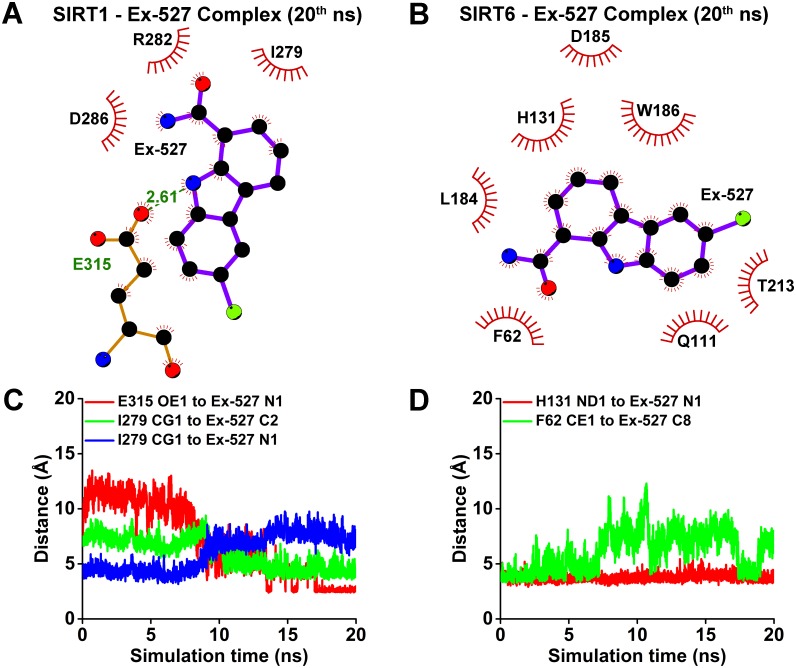
Ex-527 had more hydrophobic contacts and interacted mainly with SIRT6 active site residues compared with Ex-527 of SIRT1.Interaction schemes in (A) and (B) were obtained using Ligplot+ interaction analysis tool on the complex structures of SIRT1-Ex-527 and SIRT6-Ex-527 under high salt at the 20th ns of MD simulations. Legend for the items in (A), (B), (C) and (D) were given as supplementary information (S7 Fig). (A) Ex-527 had only one hydrophobic contact remained with the previously established hydrophobic pocket (I279) and it was held close to the hydrophobic pocket with two other hydrophobic contacts (R282, D286) together with a hydrogen bond to E315 (Bond Length: 2.61 Å). (B) Ex-527 of SIRT6 had more hydrophobic contacts than that of SIRT1 and these contacts were made almost completely with SIRT6 active site residues (H131, W186, F62, Q111, T213). Distance vs. time analysis of the selected contacts observed in (A) and (B) for the whole simulations were given as in (C) and (D), respectively. (C) Side chain carbon (CG1) of I279 of SIRT1 was closer to N1 of Ex-527 for first ~7 ns (blue), while it was nearer to C2 of Ex-527 for the rest of the simulation (green). After ~14 ns, side chain oxygen (OE1) of E315 of SIRT1 was in close proximity of N1 of Ex-527, corresponding to the newly formed hydrogen bond (red). (D) For the first ~6 ns, side chain carbon (CE1) of F62 of SIRT6 was closer to the C8 of Ex-527, but this adjacency was fluctuated for the rest of the simulation (green). Yet, active site H131 of SIRT6 was in close proximity to Ex-527 throughout the simulation, presented with distance of its side chain nitrogen (ND1) to N1 of Ex527 (red). Naming for Ex-527 atoms were given in Fig 4B.